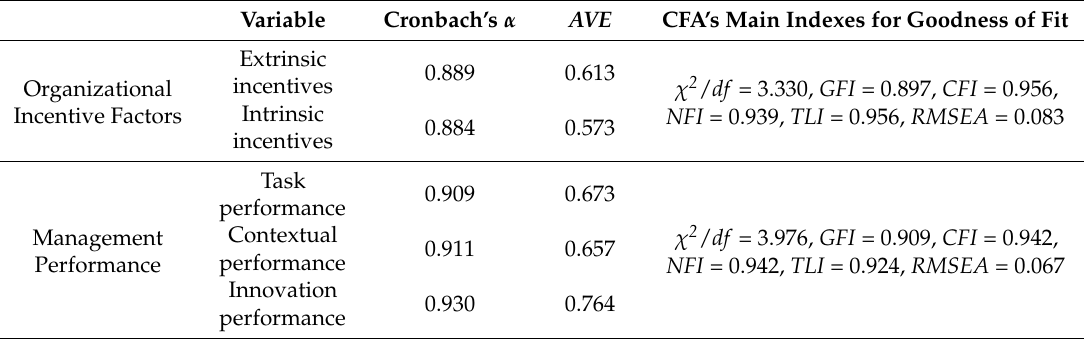
Table 1. The CFA findings of all variables and the coefficient of internal consistency.